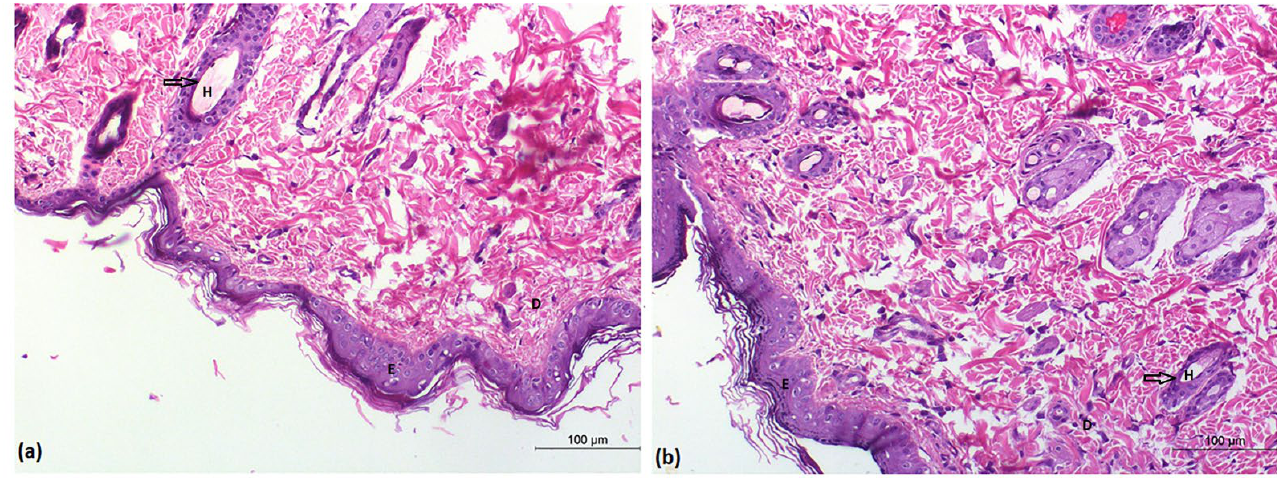
Figure 9. Representative histopathological images of untreated rat skin group ( a ); and DNa-BSVC gel treated rat skin group ( b ).